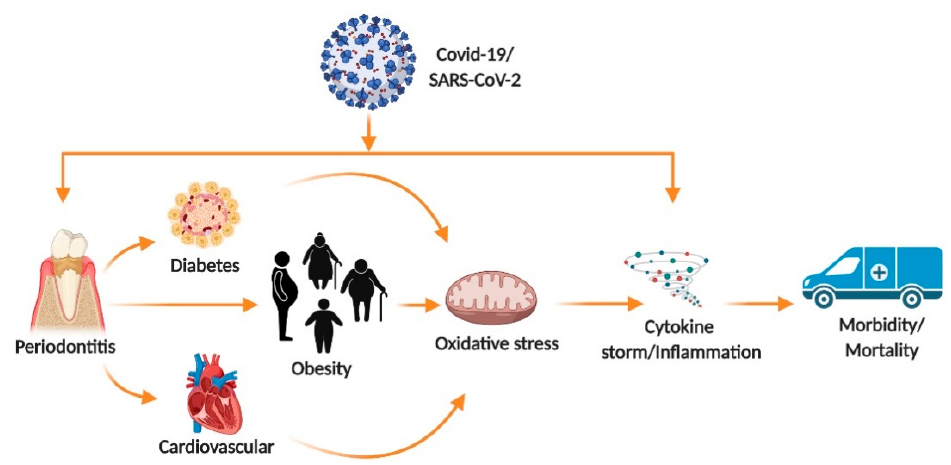
Figure 2. An overview of COVID-19 infection. COVID-19 infection is more pronounced in popula- tions with comorbidities such as periodontitis, obesity, diabetes and cardiovascular disease. COVID-19 infection induces oxidative stress, triggers unregulated cytokine production (cytokine storm) and inflammation [89–91]. These events enhance the risk of morbidity and mortality rate in most vulnerable populations [21,23].